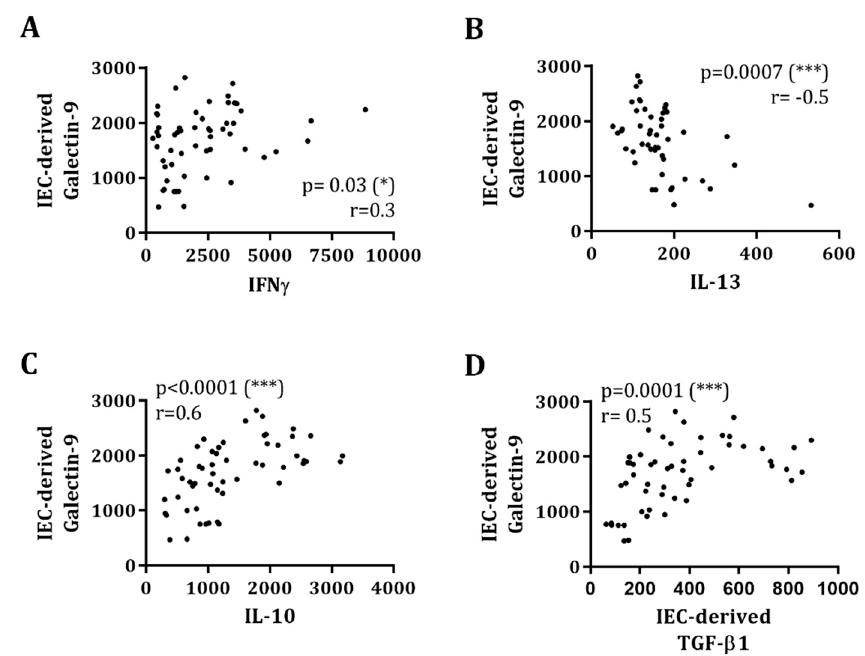
Figure 5. IEC-derived galectin-9 secretion correlates with IEC / PBMC co-culture cytokine release and IEC-derived TGF- β 1. After 24 h IEC / PBMC co-culture, IFN γ , IL-13 and IL-10 concentrations were measured in the basolateral supernatant (Figures 1A and 3). Thereafter, IEC were washed with PBS, the medium was refreshed and IEC incubated for additional 24 h (Figure 1B). After the incubation, the basolateral supernatant was collected and IEC-derived galectin-9 and TGF- β 1 were measured (Figure 4). The correlation between IEC-derived galectin-9 and IFN γ ( A ), IL-13 ( B ), IL-10 ( C ) and TGF- β 1 ( D ) release was tested using Spearman’s test (* p < 0.05, *** p < 0.001).